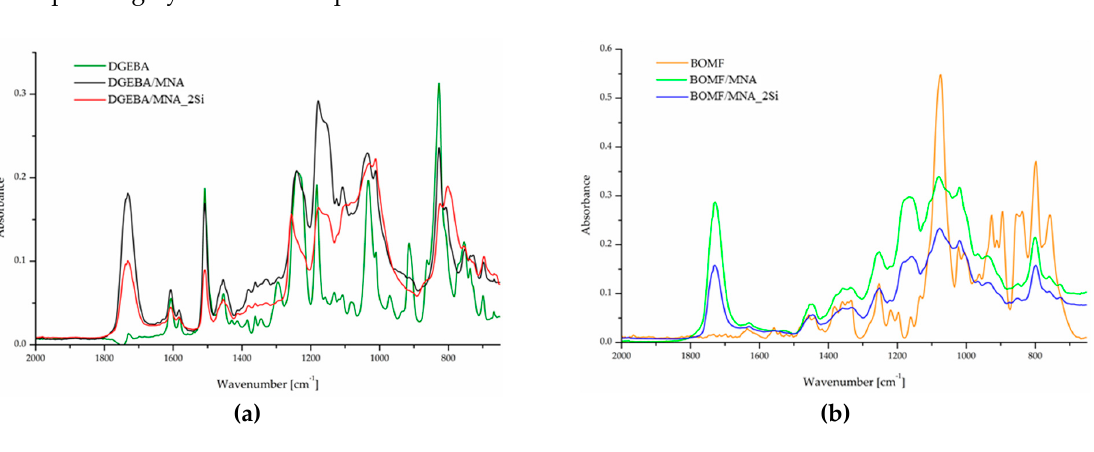
Figure 1. FTIR-ATR spectra of ( a ) DGEBA, the DGEBA-based epoxy resin (DGEBA/MNA) and epoxy/silica hybrid (DGEBA/MNA_2Si), and ( b ) BOMF, the furan-based epoxy resin (BOMF/MNA) and epoxy/silica hybrid (BOMF/MNA_2Si).